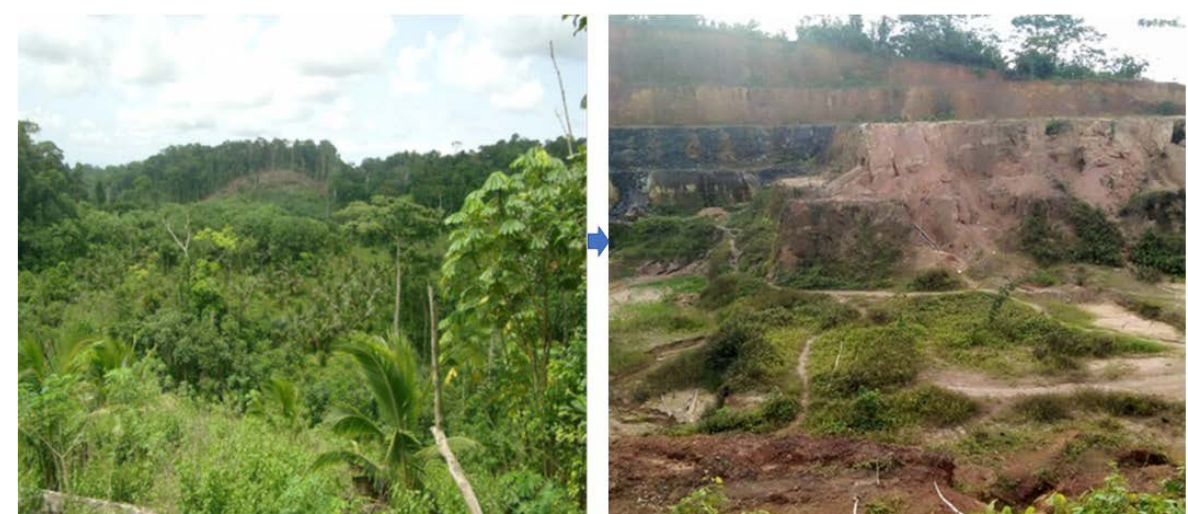
Figure 9. Destructed vegetation and land with massive erosion taking place, August (2020).